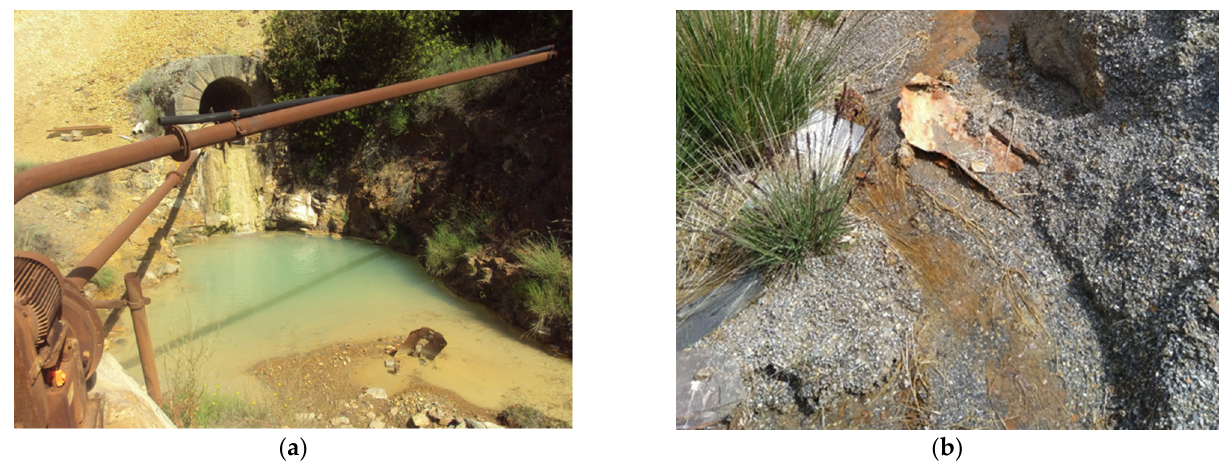
Figure 1. ( a ) Example of a drainage adit in the Montevecchio mine district (south-west Sardinia, Italy); ( b ) leachate from tailings heaps in Nant y Mwyn lead mine (central Wales, UK).